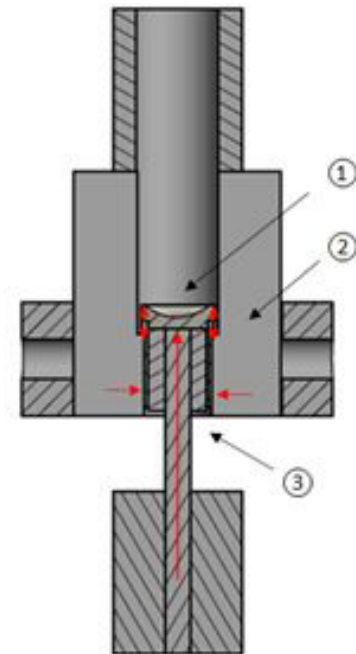
Figure 6. Arrangement to the strength test: 1 - cathode sample; 2 - clamp; and 3 - bottom